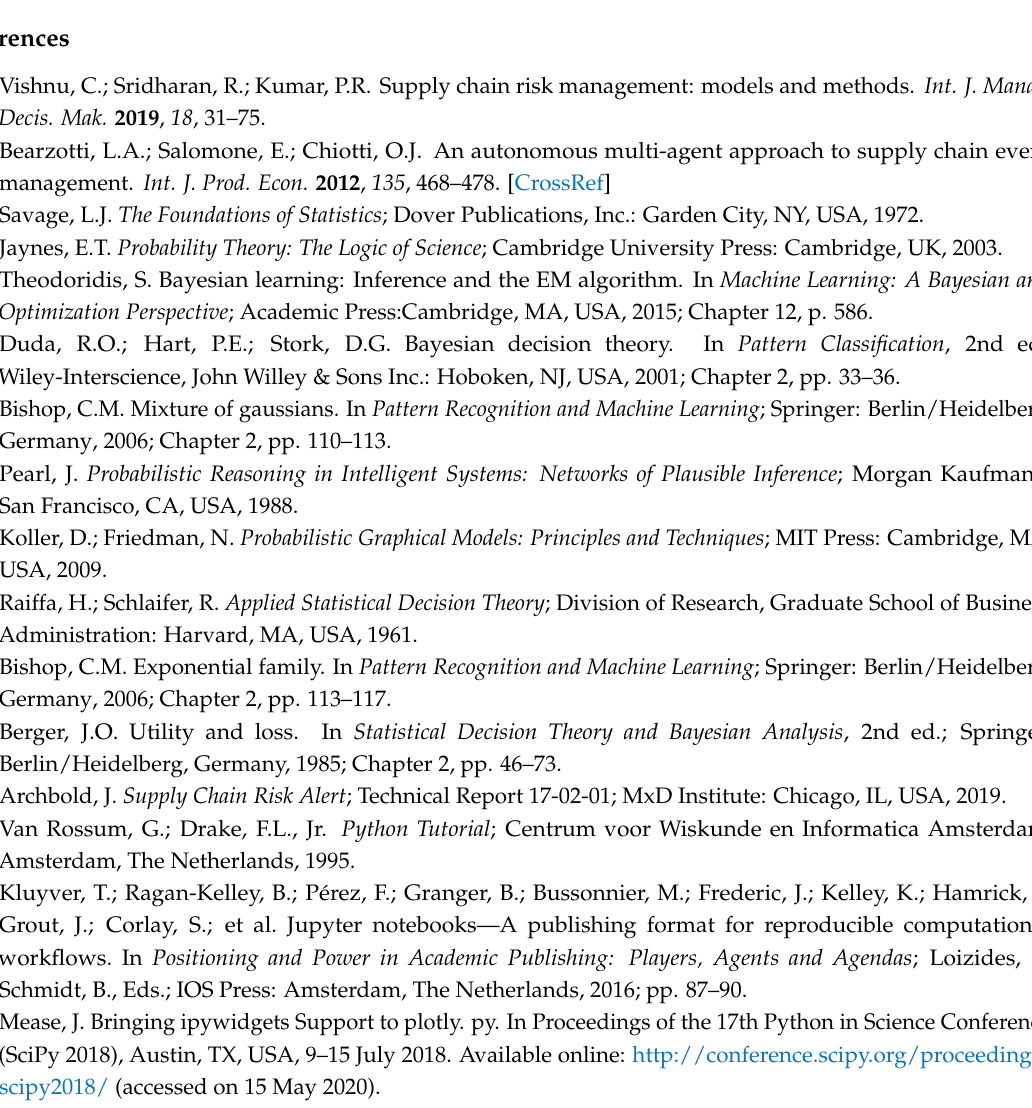
Figure A4. An example of a multi-day